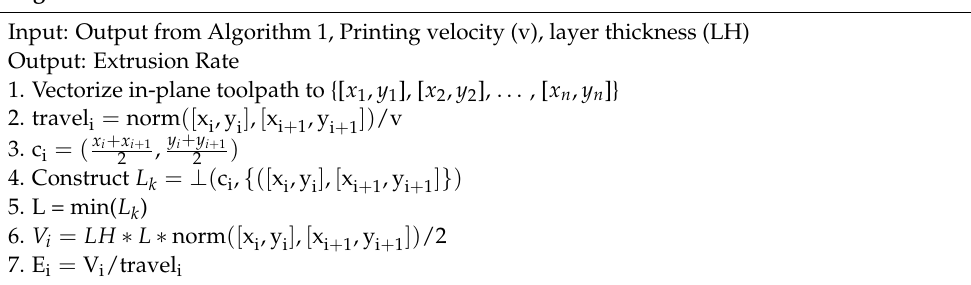
Algorithm 2: Generation of Process Parameters.